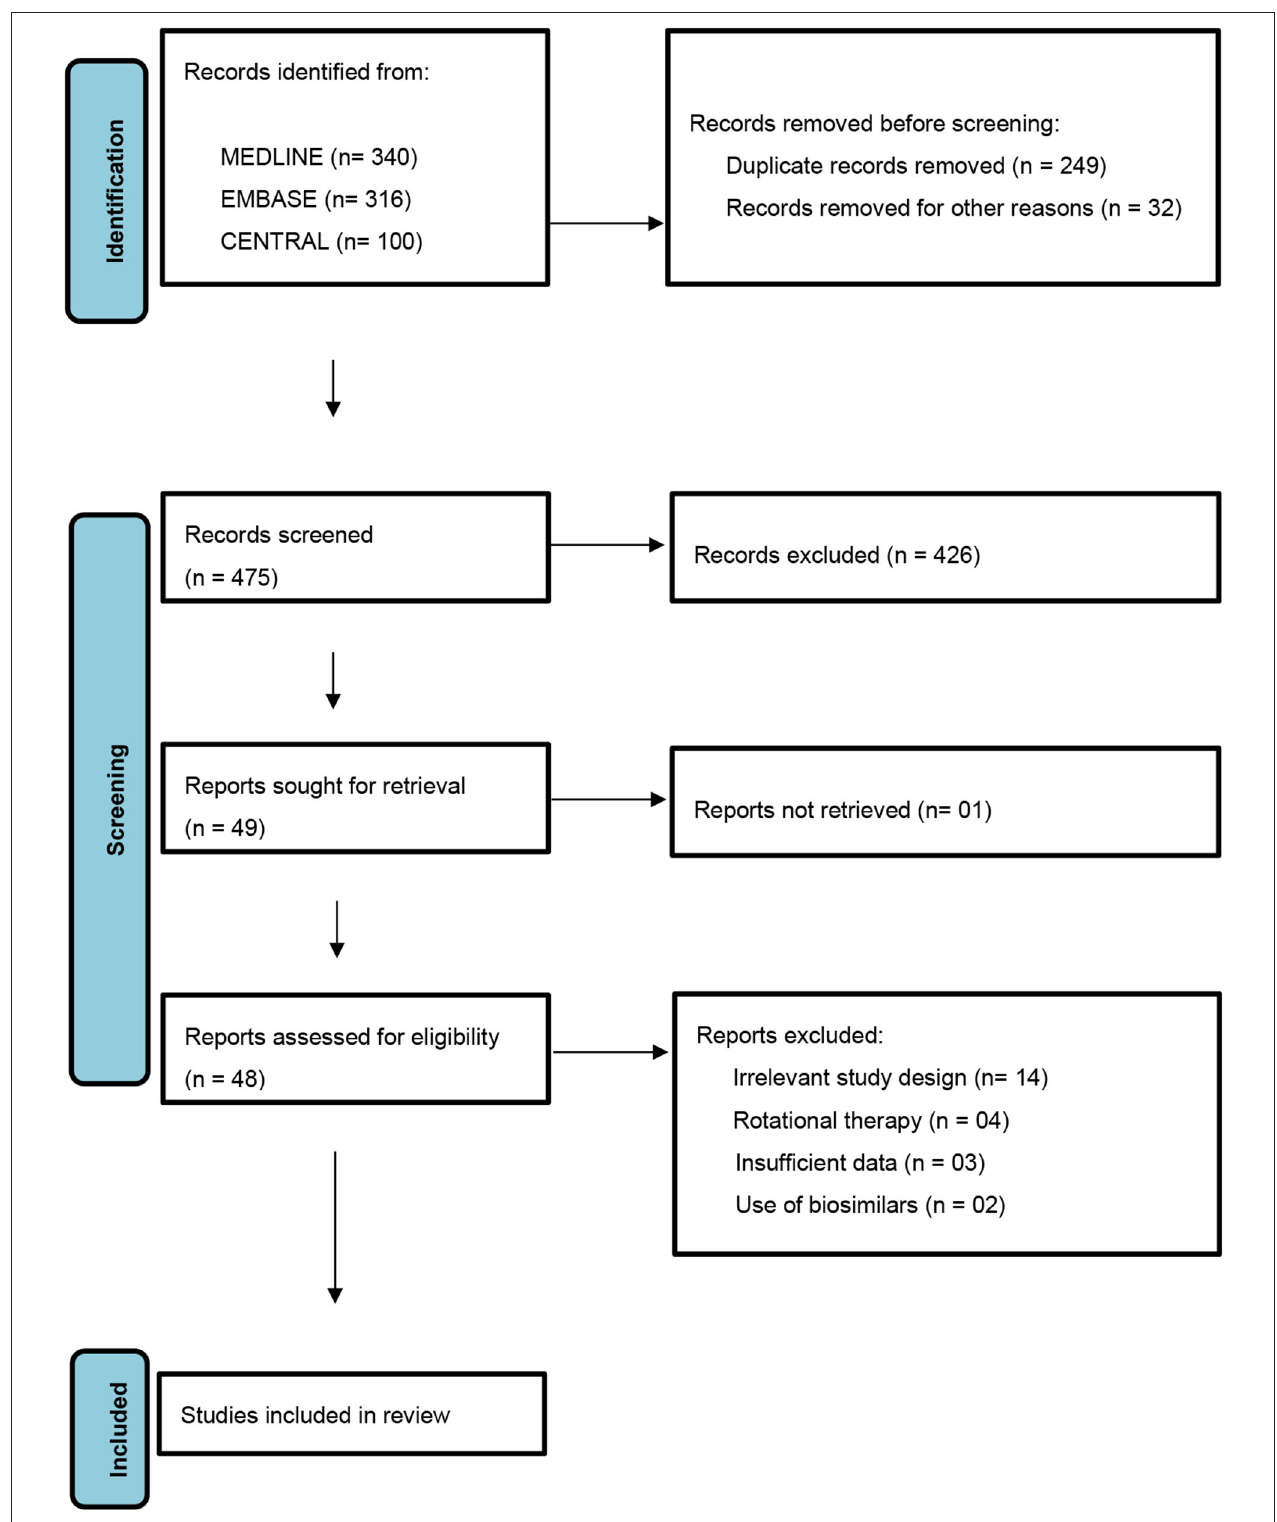
FIGURE 1 | PRISMA flow diagram for selection of studies.